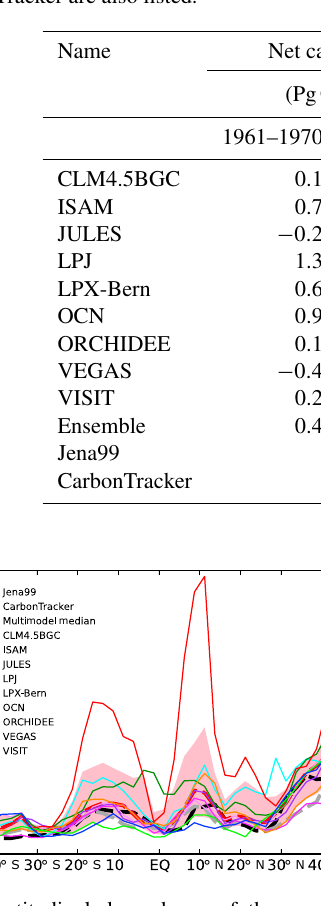
Table 3. Global mean net land carbon flux, seasonal amplitude, the maximum and minimum months of F TA for the nine TRENDY models and their ensemble mean during 1961–1970 and 2001–2010 periods. For the later period, characteristics of the atmosphere inversions Jena99 and CarbonTracker are also listed.